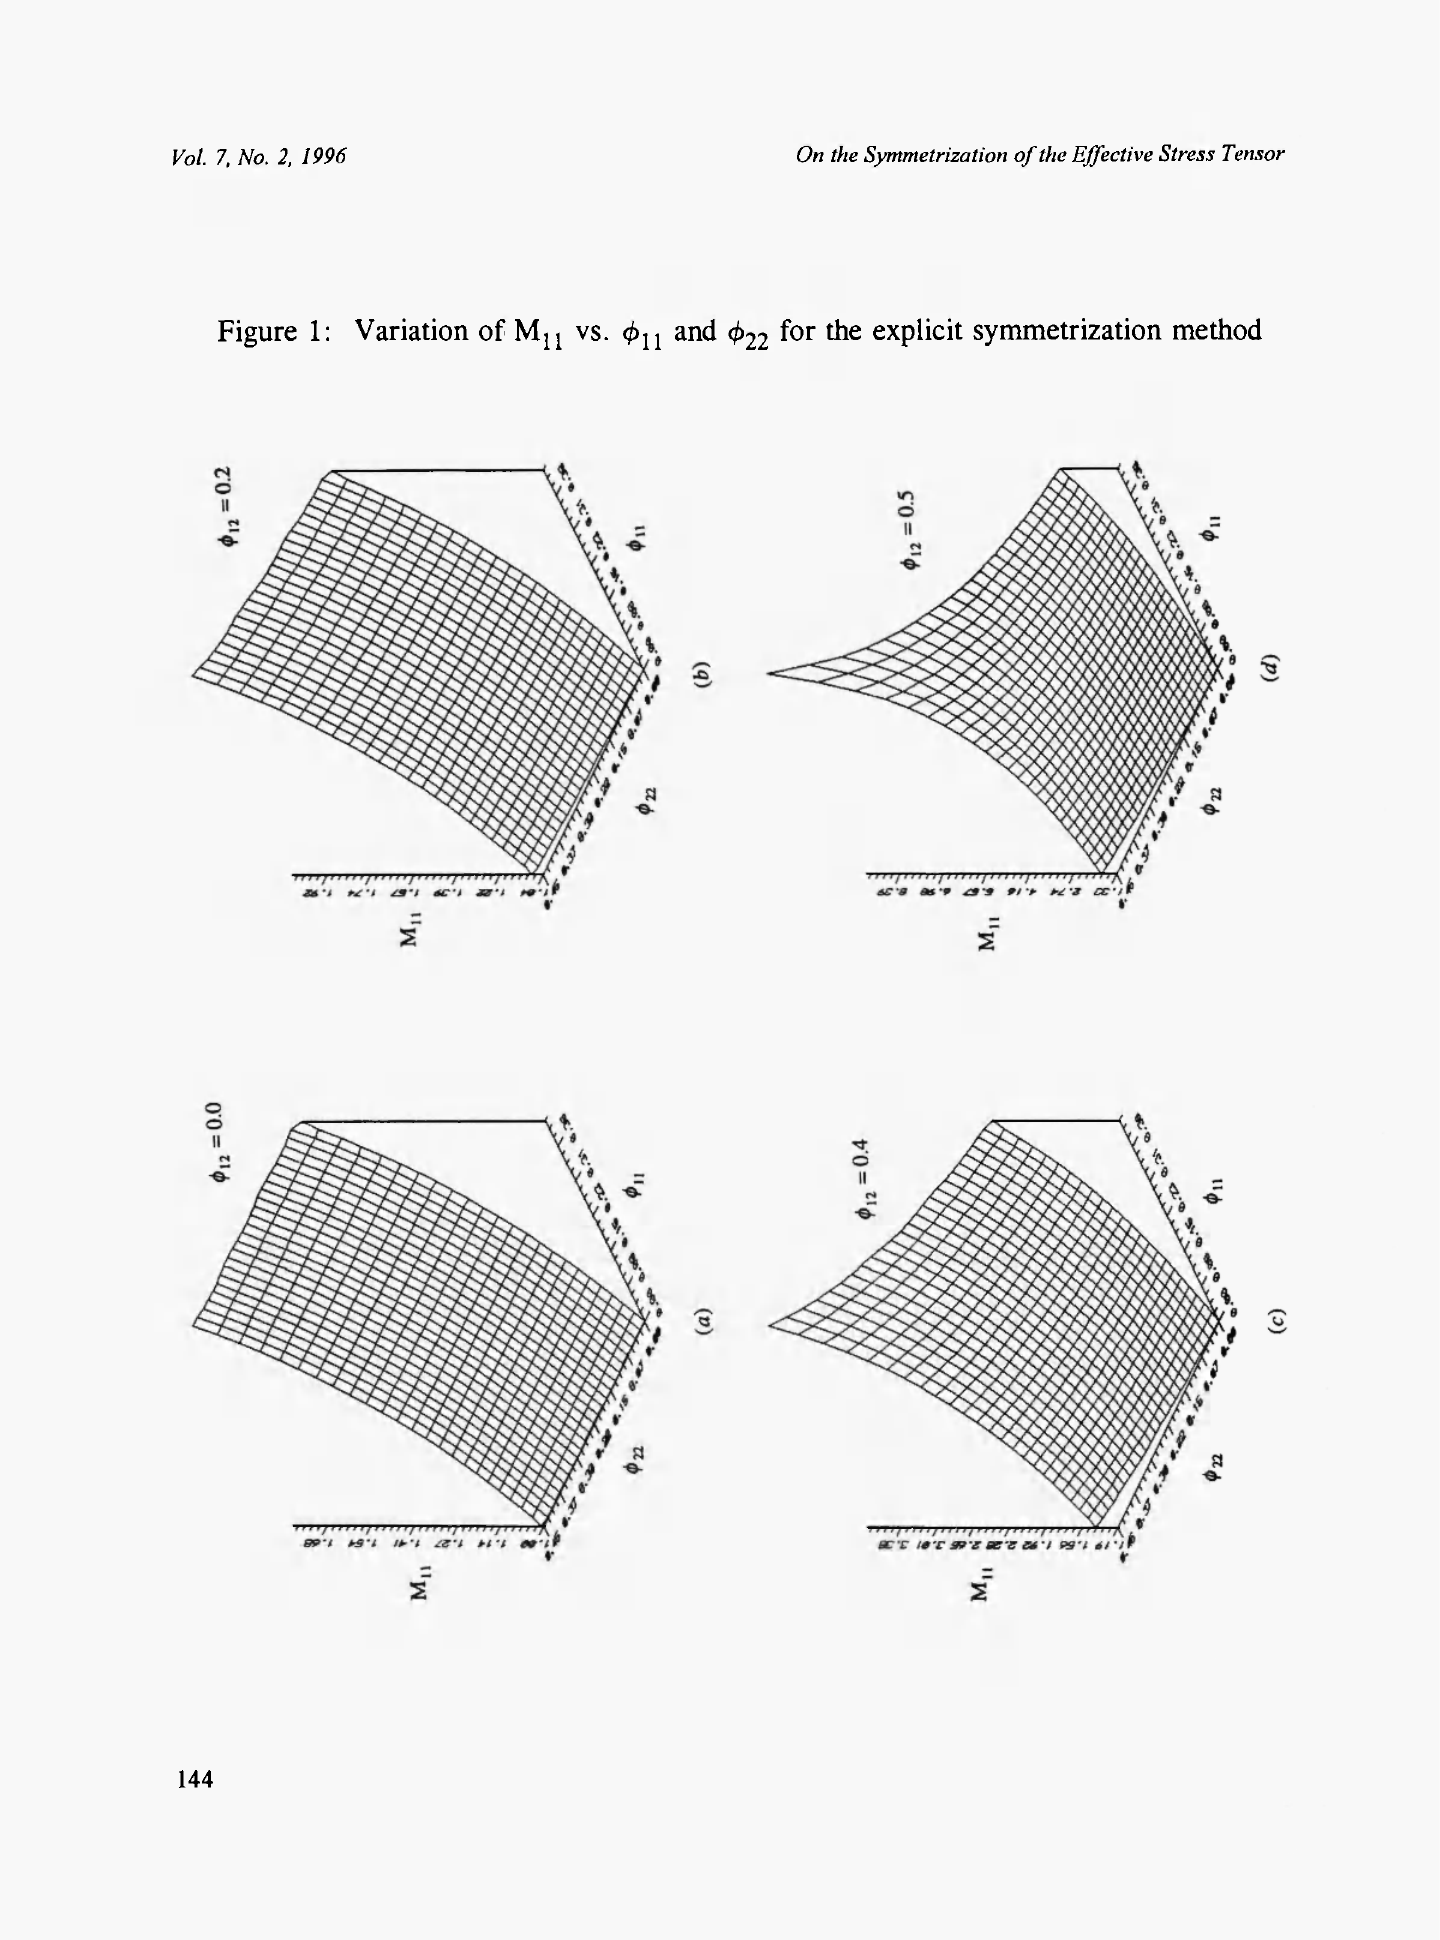
vs. φ and </> for the explicit symmetrization u η 22